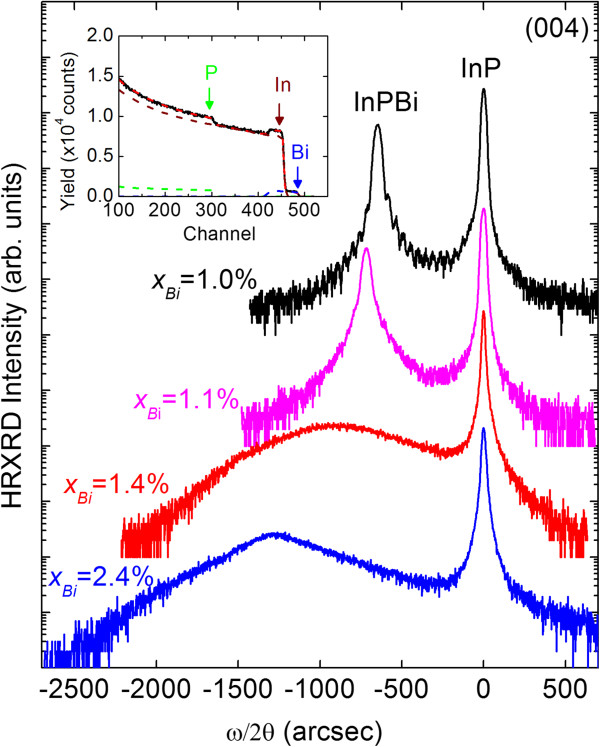
HRXRD (004) scan curves of InPBi samples with various Bi compositions. The inset shows the RBS spectrum from the InPBi film with xBi = 1.4% (solid line). The simulated spectrum and the contributions of Bi, In, P are also contained (dashed lines).